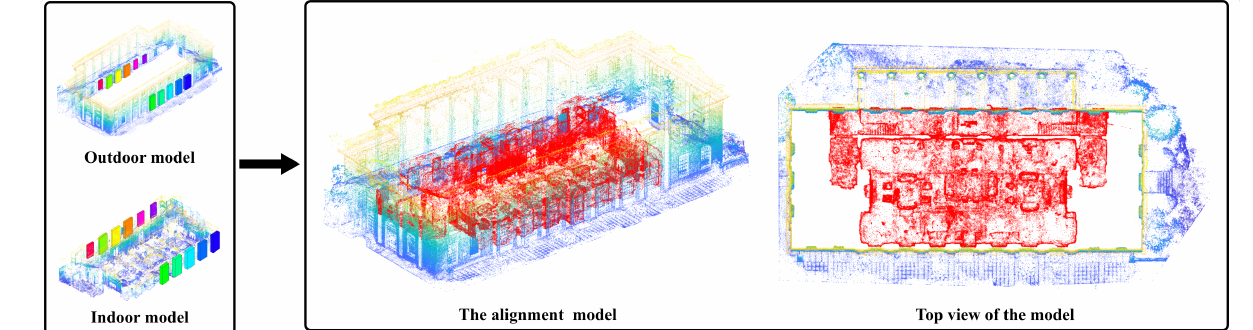
Figure 15. The registration result for the public dataset “Hall”. The windows and doors for indoor and outdoor models were labeled manually, and the registration was conducted with the proposed SGD-based method. The alignment result is illustrated on the right side of the image, and there are no visually observable